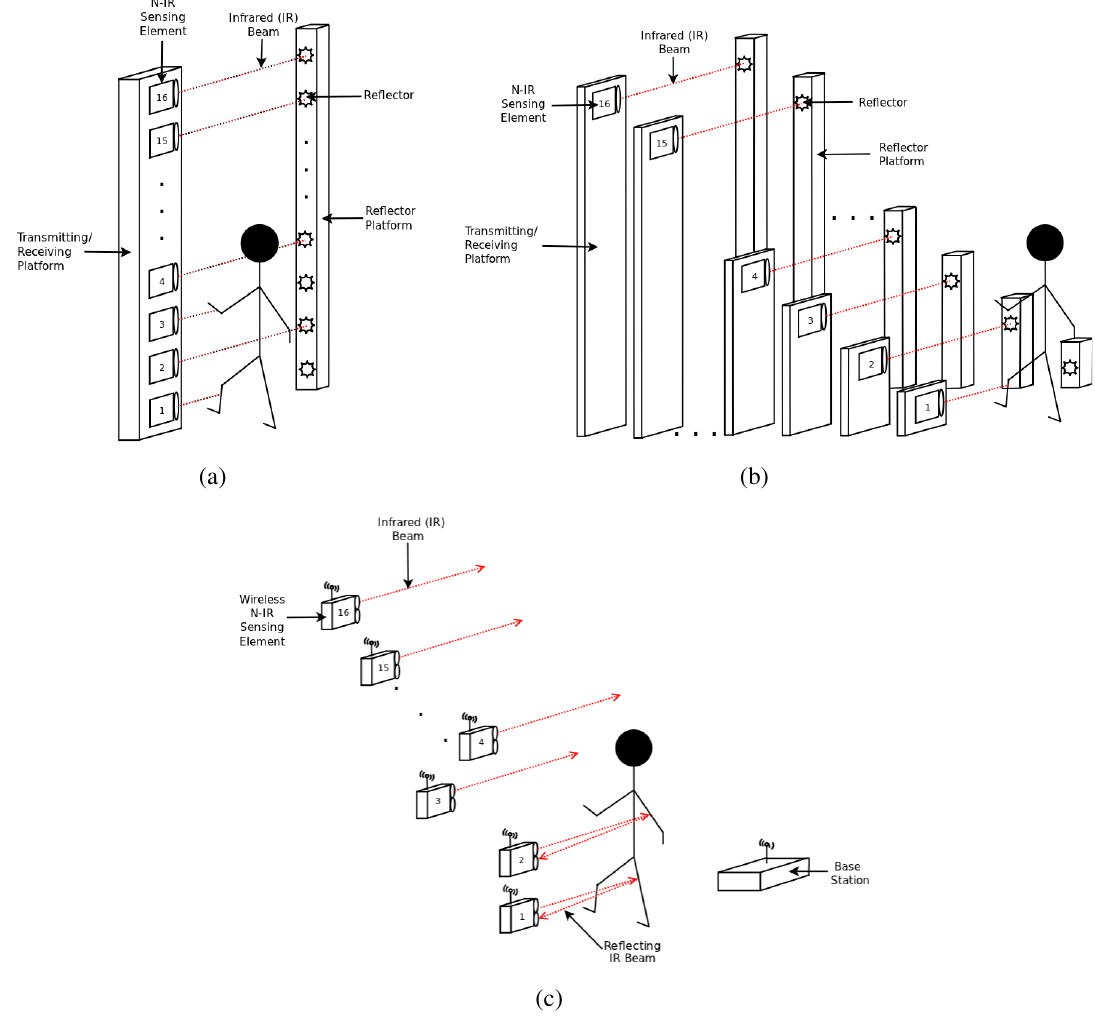
Figure 1. N-IR profiling sensor. ( a ) Sparse vertical array of wired detectors; ( b ) Sparse vertical array of wired detectors with custom horizontal offset; ( c ) New wireless profiling sensor comprised of sixteen N-IR sensing